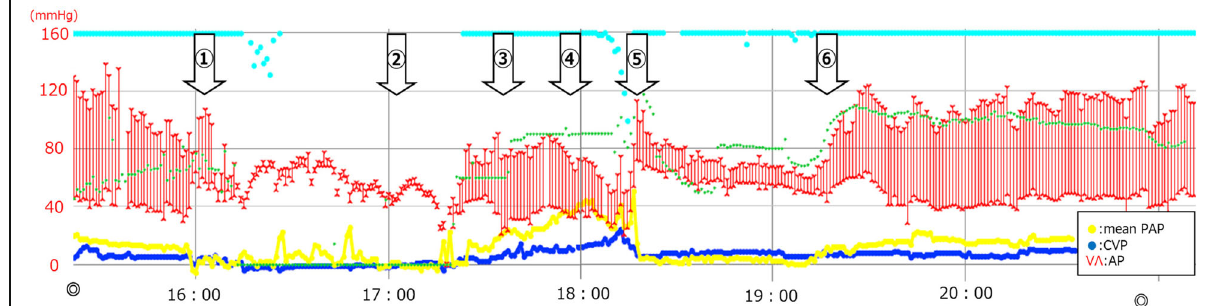
Fig. 4 Anesthetic record. ◎ start/end of surgery. PAP pulmonary artery pressure, CVP central venous pressure, AP arterial pressure, ① start of CPB, ② AVR, ③ withdrawal of CPB, ④ signs of left heart failure and appearance of left ventricular wall motion abnormality, ⑤ second run of CPB, ⑥ second withdrawal of